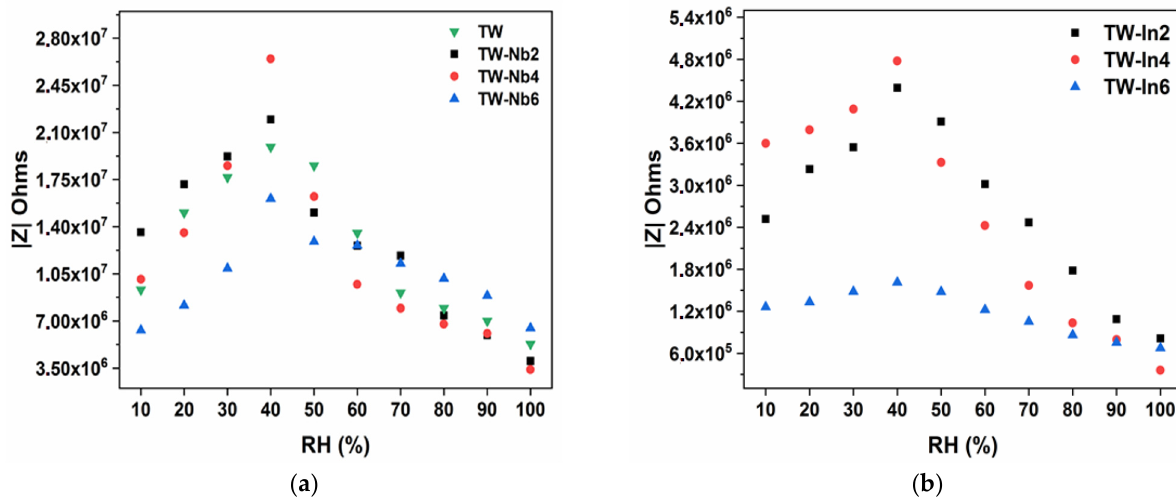
Figure 8. ( a ) Impedance variation with RH for ( a ) 𝑇𝑊 − 𝑁𝑏 and ( b ) 𝑇𝑊 − 𝐼𝑛 mixed metal oxides at 1 kHz and 20 °C .